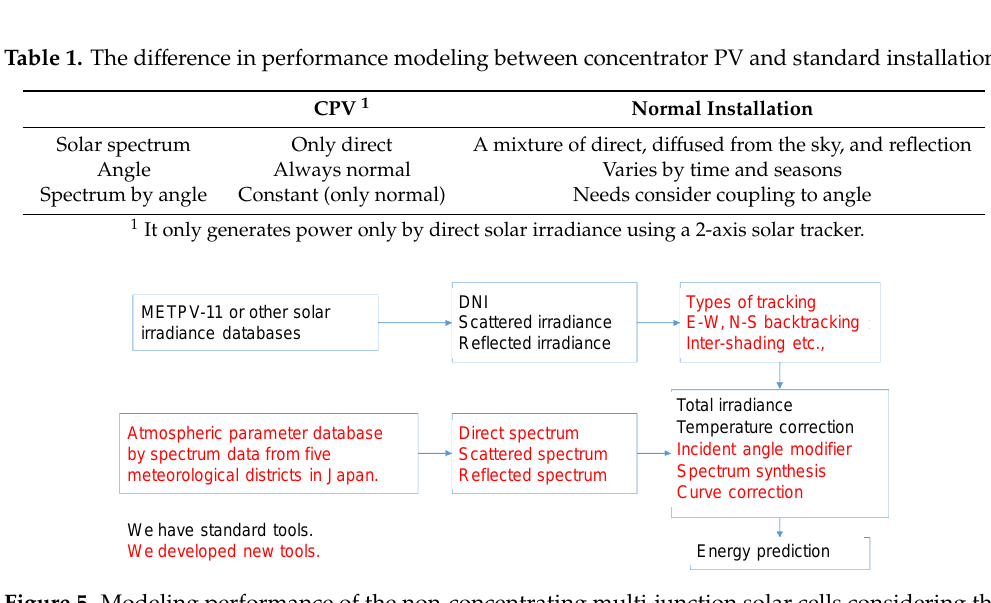
Figure 5. Modeling performance of the non-concentrating multi-junction solar cells considering the complicated spectrum and angle interaction described in Table 1. In this study, we only considered the flat plate, so that correction to the curved surface in the integrated tool was not applied.